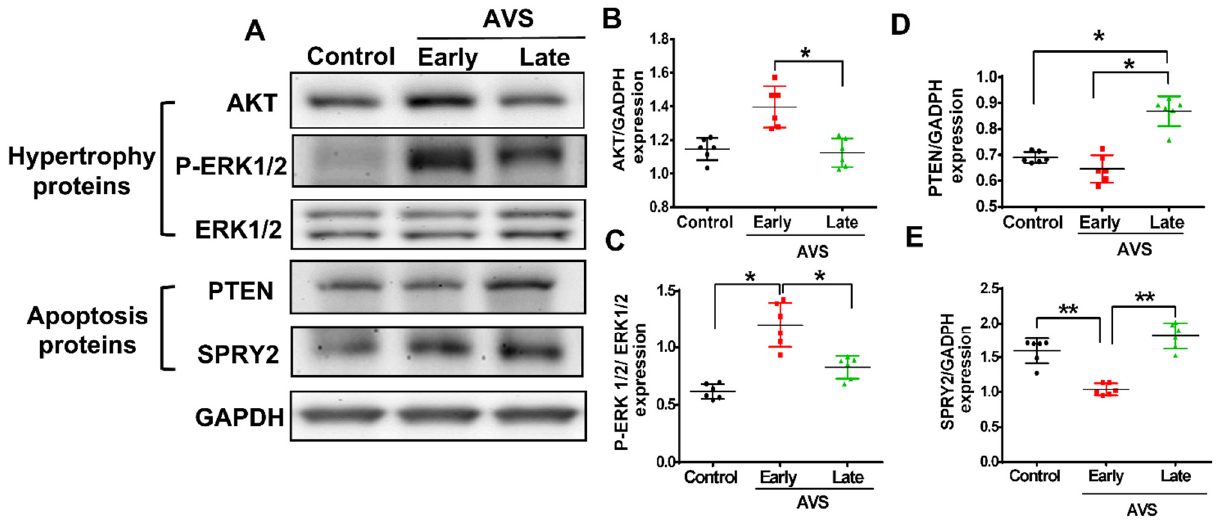
Figure 4. Pulmonary arterial hypertension (PAH) triggers early expressions of hypertrophy-associated proteins and sub- sequently late expressions of apoptosis-associated proteins in the right ventricle (RV) of rats subjected to arteriovenous shunt (AVS). ( A ) Representative hypertrophy and apoptosis-associated protein in early (7 days) and late (28 days) phase in RV of rat subject to AVS by western blot analysis. Quantification of ( B ) AKT, ( C ) p-ERK, ( D ) PTEN and ( E ) SPRY2 protein expression. Data are expressed using mean ± standard deviation (S.D.). * p < 0.05 and ** p < 0.01, for difference between each group. (N = 6–8).